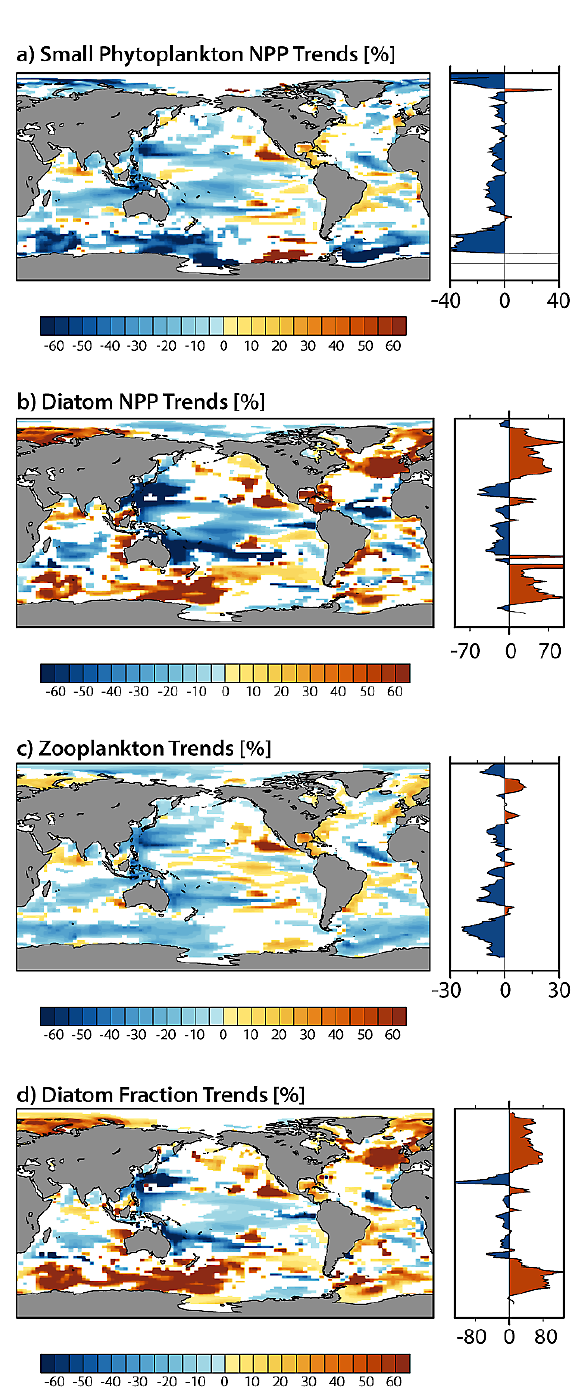
Fig. 4. Simulated percentual changes between 1960 and 2006 in (a) small phytoplankton NPP and (b) diatom NPP, (c) zooplank- ton biomass and (d) resulting changes in diatom fraction. The small panels to the right of each map show the zonal mean of the respec- tive map. Changes have been calculated using a linear regression on annual mean model output. Areas with insignificant changes ( p value of the regression is less than 0.05) are shown in white. More details on calculation of trends are given in Sect.